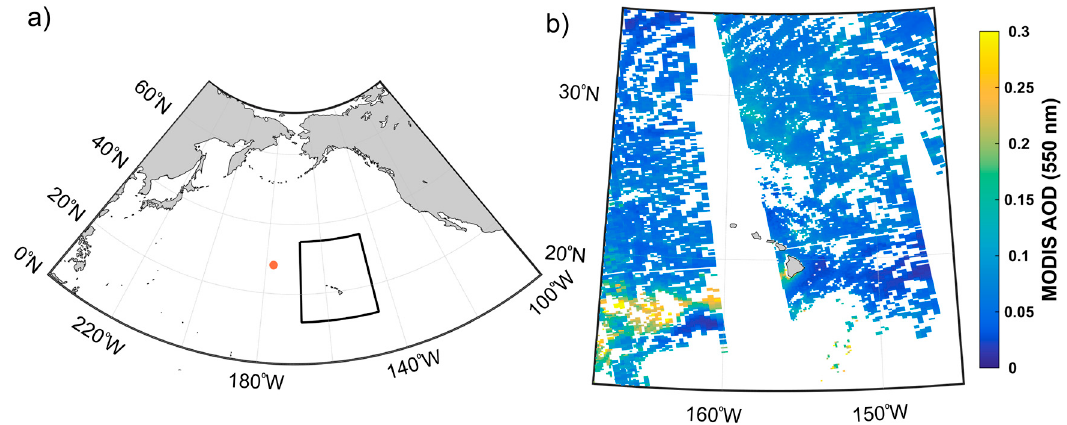
Figure 1. The investigation area (12° N–35° N, 145° W–168° W) in the central North Pacific is shown in ( b ) and denoted with a black box in ( a ). Aerosol optical depths (AODs) were derived based on MODIS Aqua observations on 18 September 2014 (right). Aerosol Robotic Network (AERONET) ground-based data were obtained from the stations at Coconut Island (21.4° N, 157.8° W) and Lanai (20.7° N, 156.9° W) on Hawaii, as well as from Midway (28.2° N, 177.4° W) west of the investigation area (orange solid circle in ( a )).